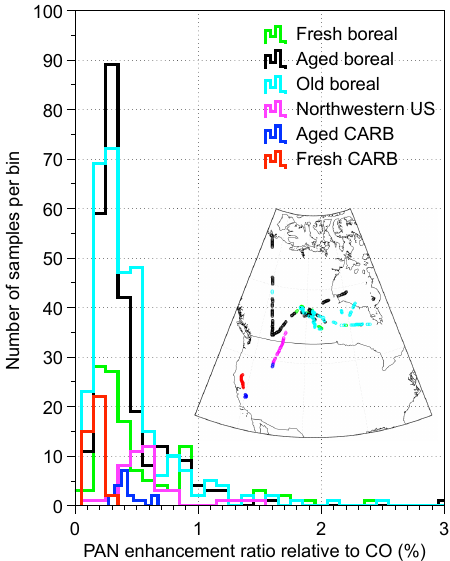
Figure 9. Histogram of estimated PAN enhancement ratios based on in situ measurements of fire plumes described in Hecobian et al. (2011) from the ARCTAS campaign. Enhancement ratios were calculated using the 25th percentile for each trace gas during the corresponding flight day. These ratios were calculated using the 1min merged